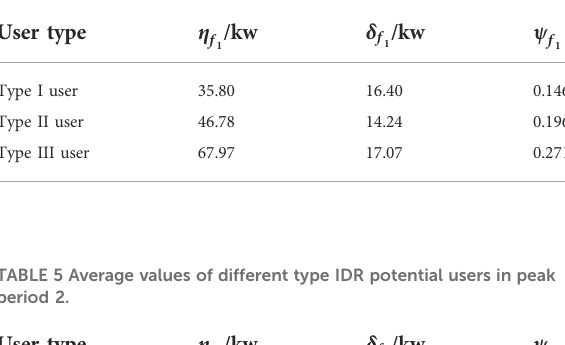
TABLE 4 Average values of different type IDR potential users in peak period 1.